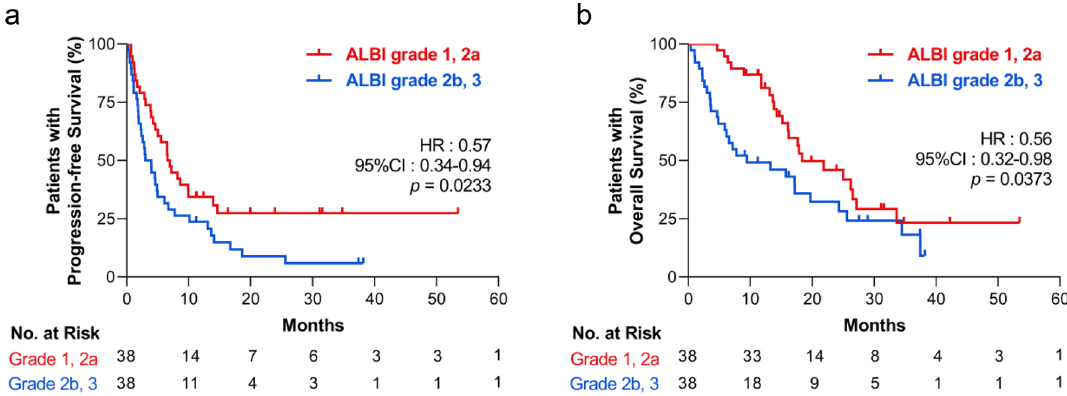
Figure 2. Kaplan–Meier survival analysis according to pre-treatment ALBI grade in patients who were selected by propensity score matching. ( a ) Progression-free survival and ( b ) overall survival. (N = 76). ALBI, albumin– bilirubin; HR, hazard ratio; CI, confidence